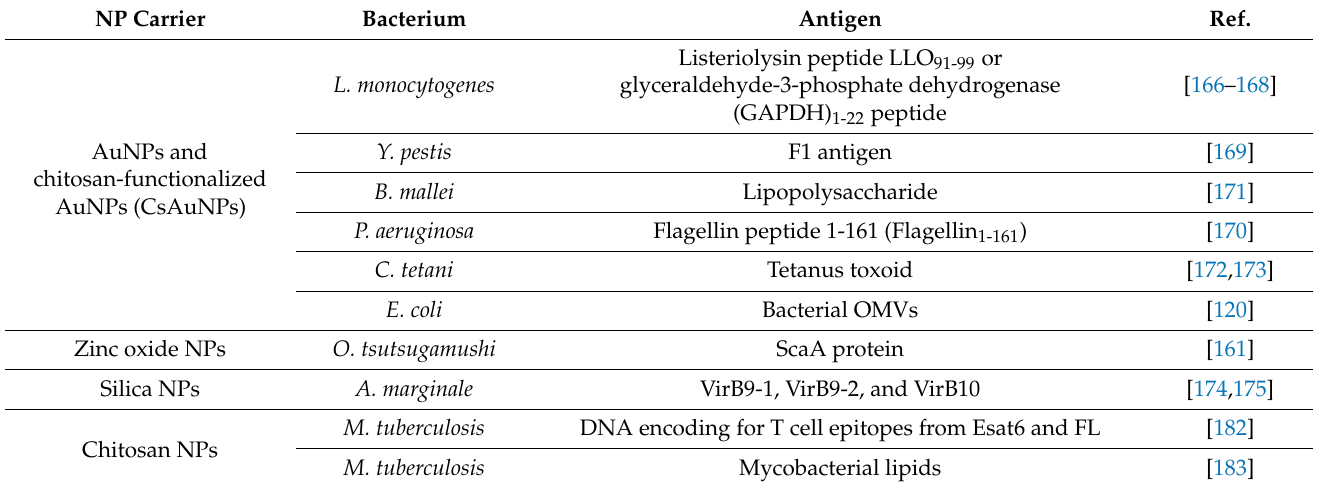
Table 3. Antigen and DNA delivery with NPs in experimental vaccination against bacterial